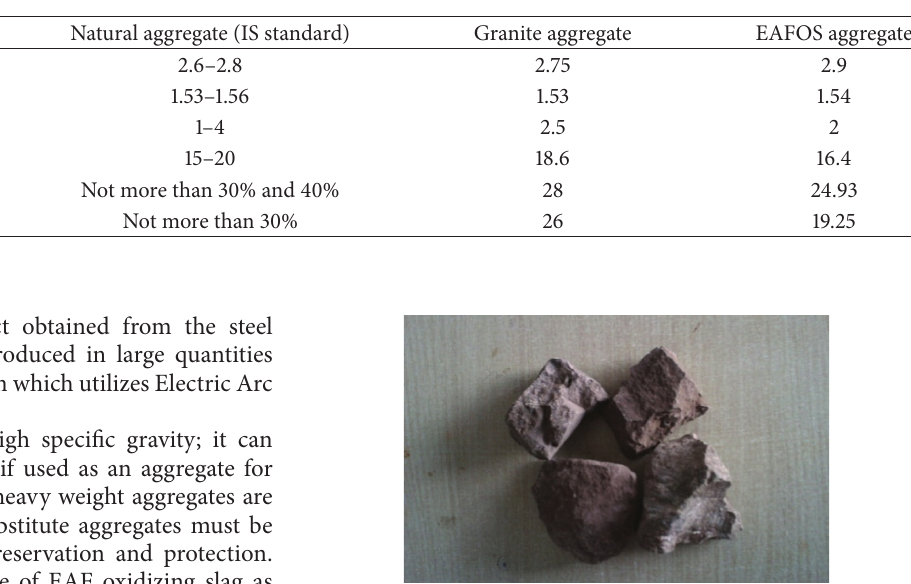
Table 1: Physical properties of EAF oxidizing slag versus natural coarse aggregate.